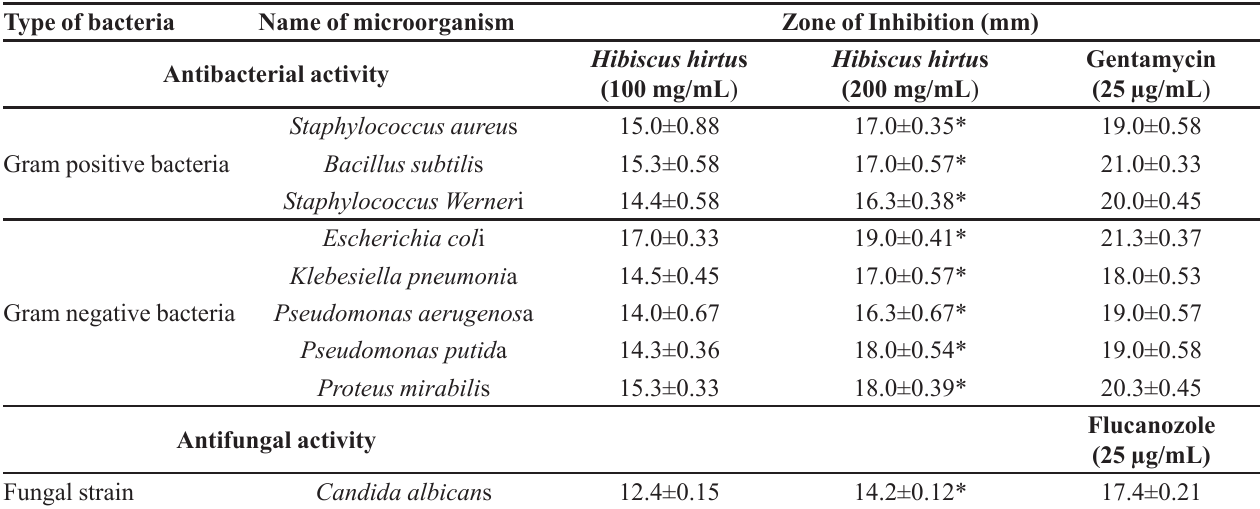
TABLE V - Zone of inhibition of ethanolic extract of Hibiscus hirtus Type of bacteria